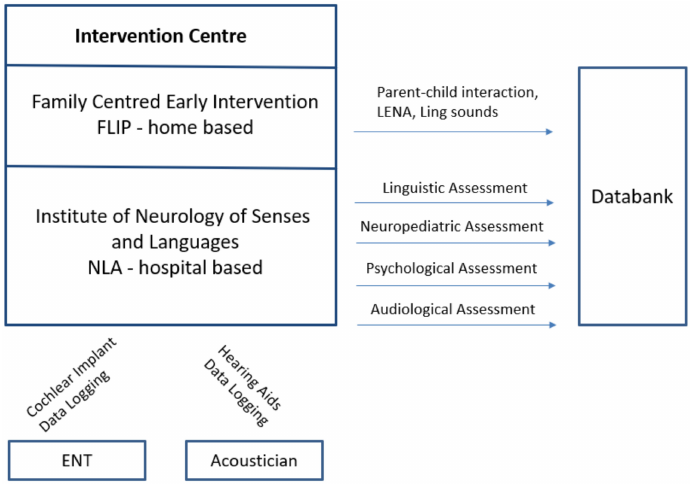
Figure 1. Data collection process.